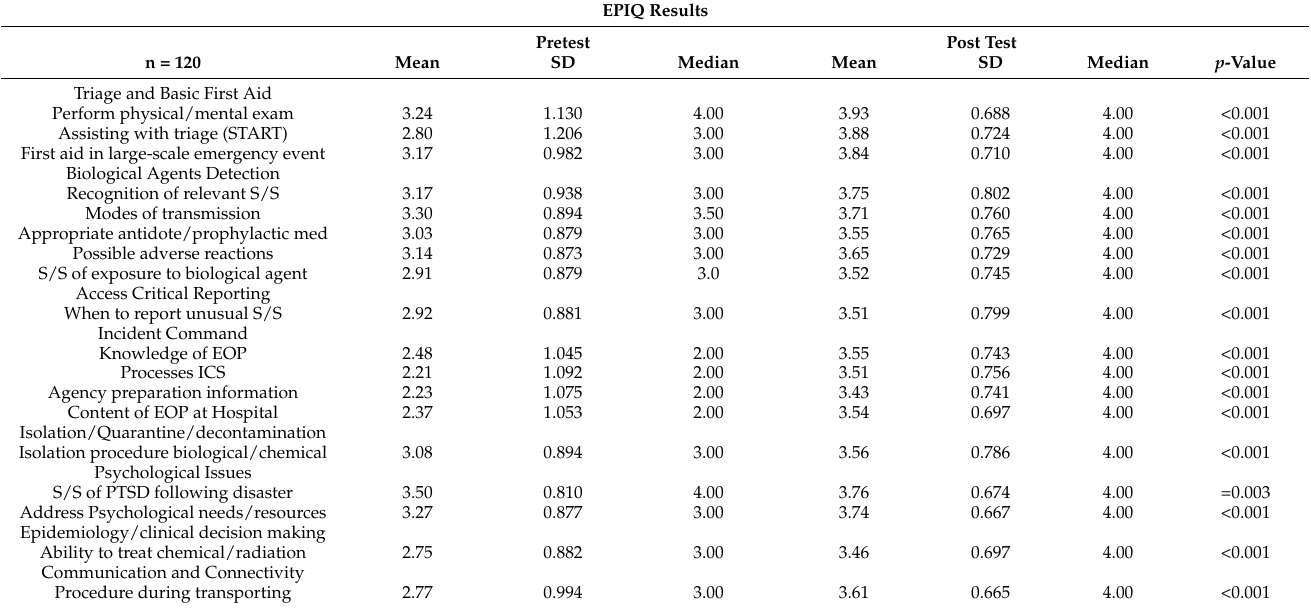
Table 2. Results from a Mass Casualty Simulation using a pre-post Emergency Preparedness Infor- mation Questionnaire (EPIQ) with interprofessional students in November 2021. (n = 120).